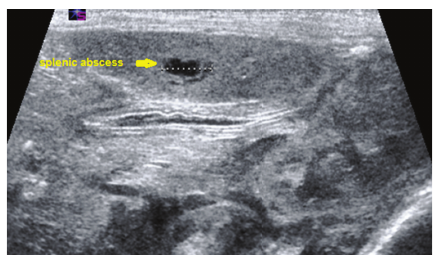
Figure 2: US examination demonstrating solitary small well- defined splenic